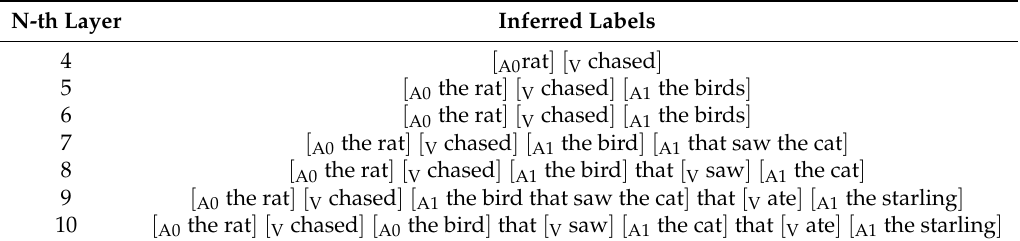
Table 4. Example sentence with parsed hierarchical